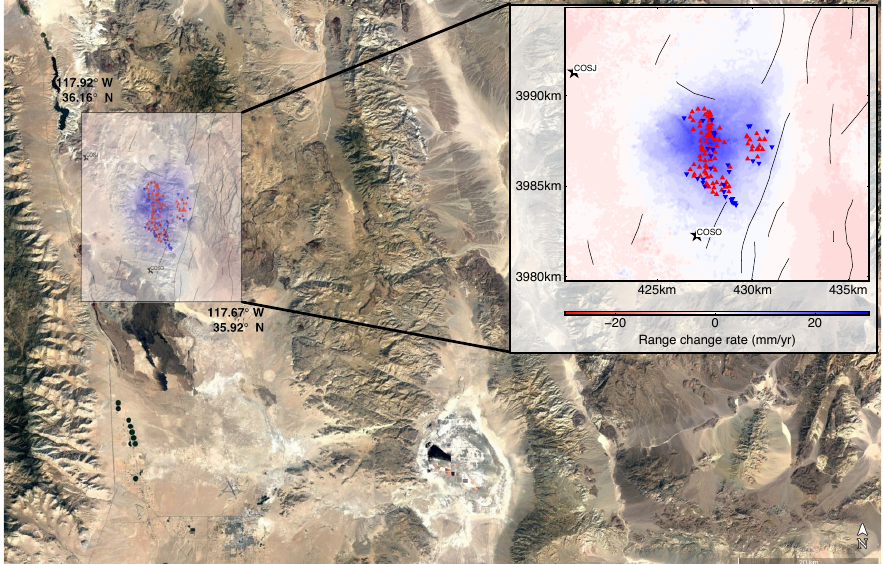
Figure 1. Geographical location of Coso geothermal field. The inset interferogram shows the field of stacked unwrapped range change rate ¯˙ ρ ( E , N ) from 81 Environmental Satellite (Envisat) pairs. The pairs span from 2004 to 2010 and are selected using a minimum spanning tree algorithm according to orbital separation. Production wells are shown as upright, red triangles and injection wells are shown as inverted, blue triangles. Global positioning system (GPS) stations are labeled and denoted with black stars. Coordinates are easting and northing (km) in the Universal Transverse Mercator (UTM) projection zone 11N, WGS84 [28]. Faults from Jennings [30] and Jennings et al. [31] are shown as thin black lines. The interferogram is overlaid on a 2017 Landsat/Copernicus image from Google Earth.